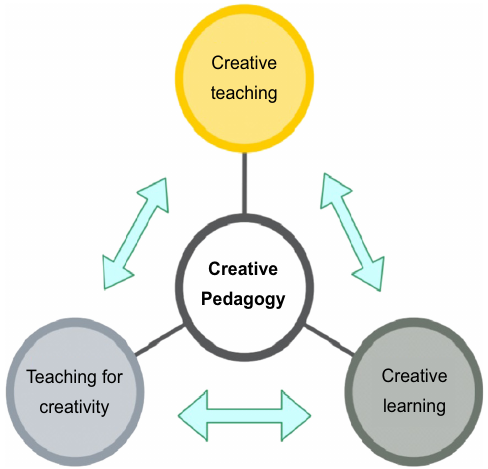
Figure 1. The conceptual frameworkofthestudy based on Lin ’ s creative pedagogy